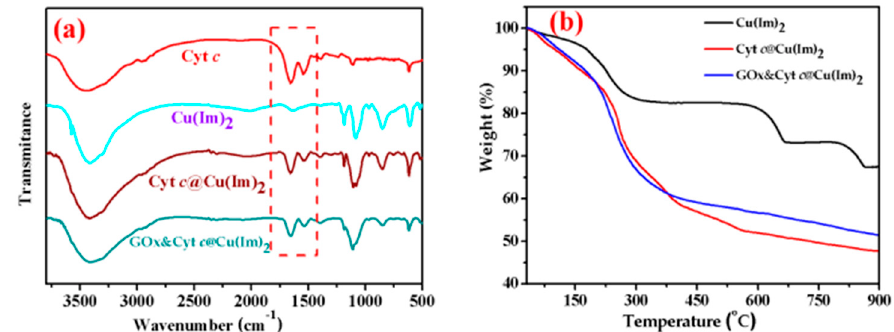
Figure 2. ( a ) FTIR spectra of Cyt c , Cu(Im) 2 , Cyt c @Cu(Im) 2 and GOx-Cyt c @Cu(Im) 2 ; ( b ) TGA curves of Cu(Im) 2 , enzyme@Cu(Im) 2 in N 2 atmosphere. Table 1. Mass loss (%) of Cu(Im) 2 and enzyme@Cu(Im) 2 composite.